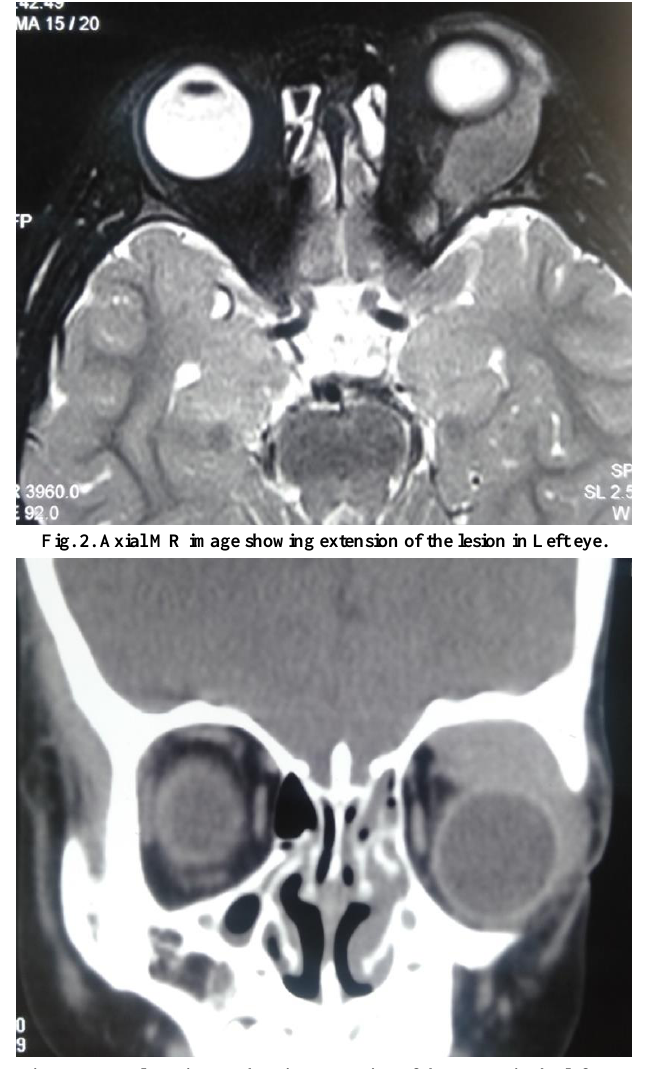
Fig. 3. Coronal CT image showing extension of the tumor in the left eye.